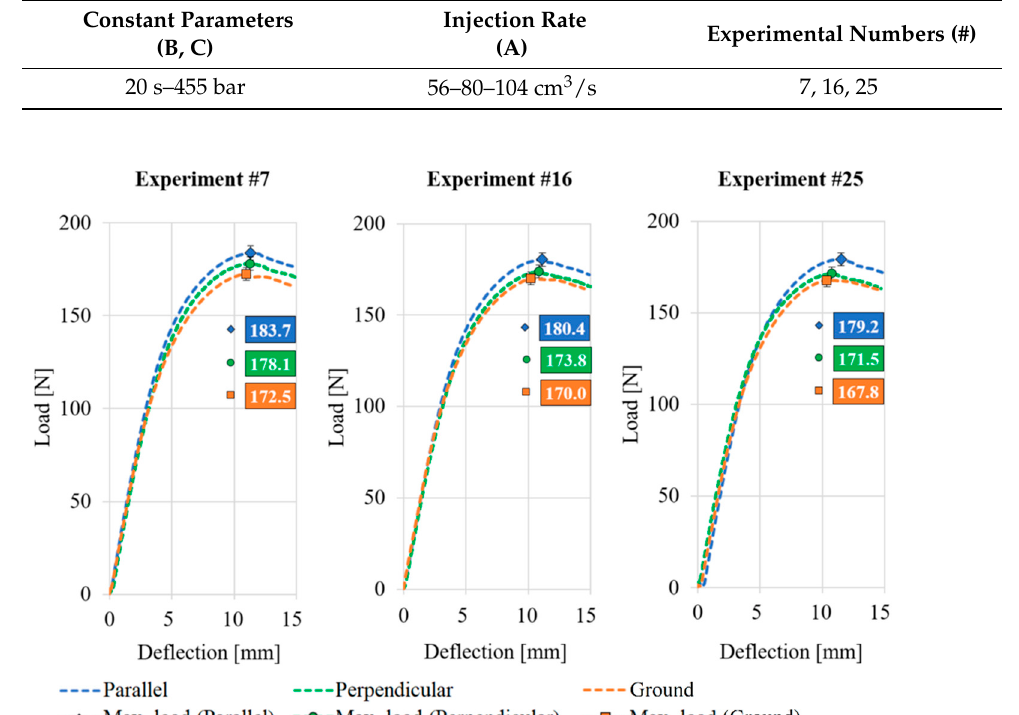
Table 8. Experiments with constant parameters (lowest cooling time and highest packing pressure) and variable injection rates.